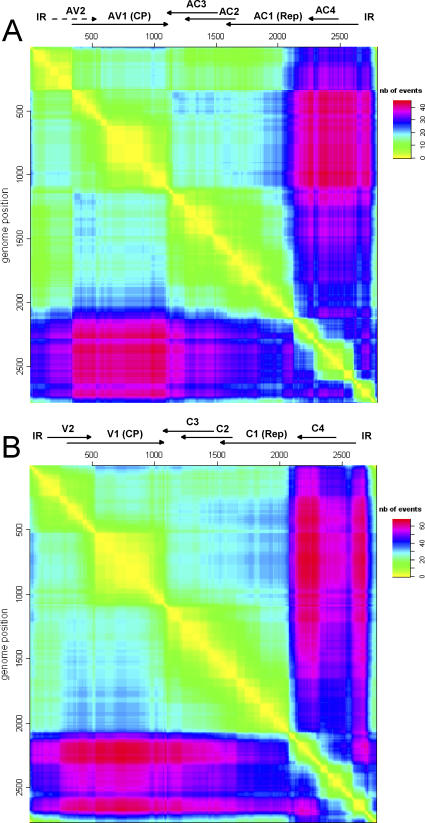
Recombination Region Count Matrix of Unique Recombination Events Detected amongst (A) DNA-A Sequences of Bipartite Begomoviruses and (B) DNA-A-Like Sequences of Monopartite BegomovirusesUnique recombination events have been mapped onto the matrix based on their estimated breakpoint positions. The shades displayed are a function of the number of times pairs of nucleotides (plotted on the x- and y-axis) are separated during the observed set of unique recombination events. Diagrams indicating the positions of landmarks in begomovirus DNA-A/DNA-A-like sequences are shown on the top of the matrices. Positions were drawn in relative to EACMCV-[TZ] (AY795983) for bipartite sequences and ToLCYT-[Dem] (AJ865341) for monopartite sequences.